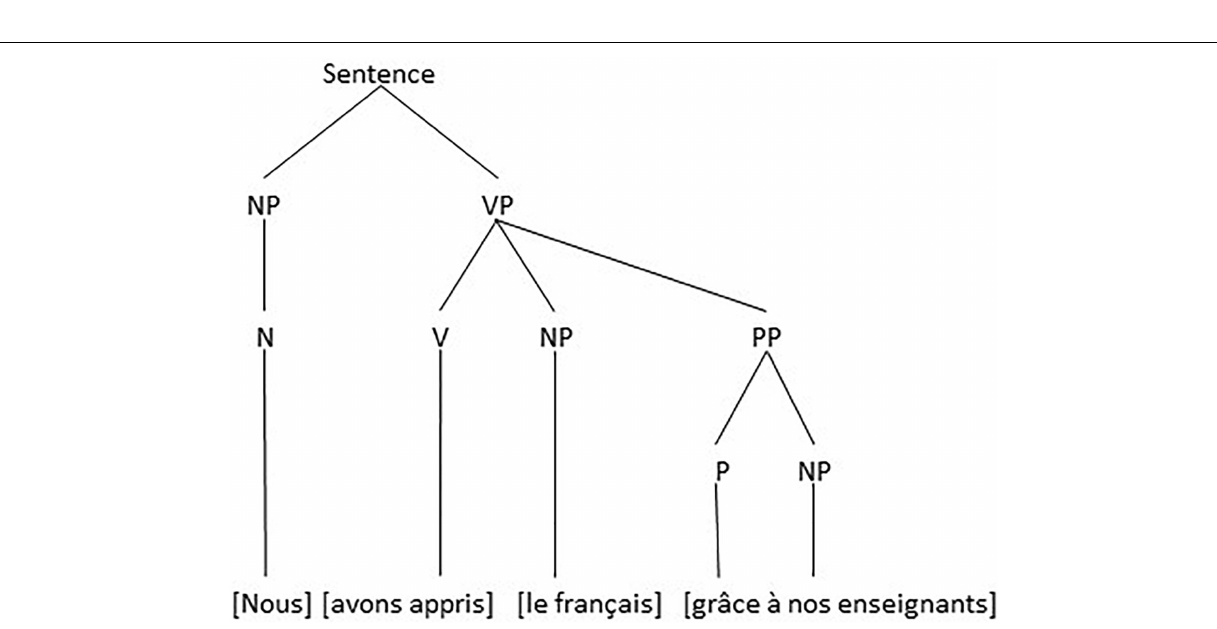
FIGURE 2 | The M orphosyntactic structure of utterance